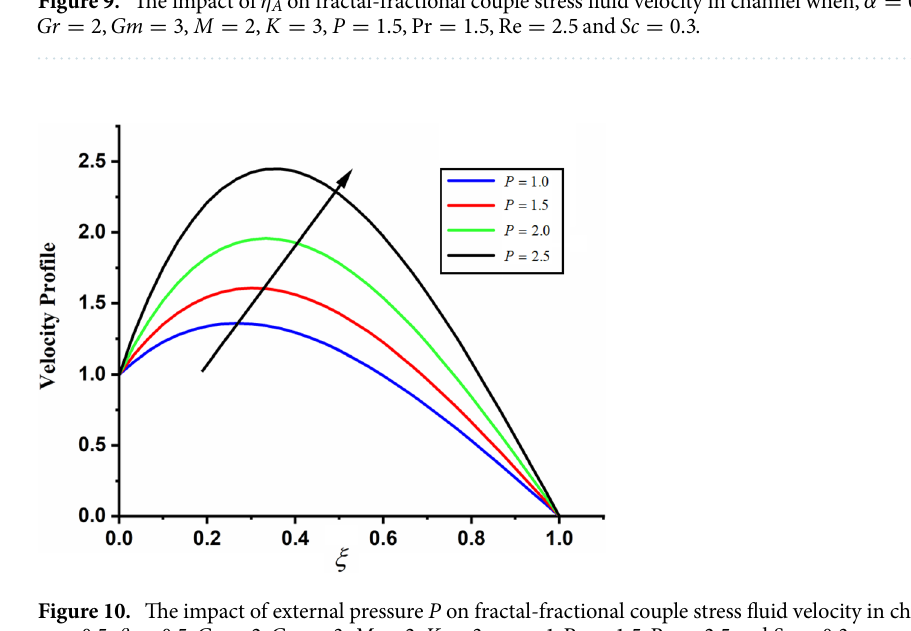
Figure 10. The impact of external pressure P on fractal-fractional couple stress fluid velocity in channel when, α = 0.5 , β = 0.5 , Gr = 2 , Gm = 3 , M = 2 , K = 3 , η A = 1 , Pr = 1.5 , Re = 2.5 and Sc = 0.3